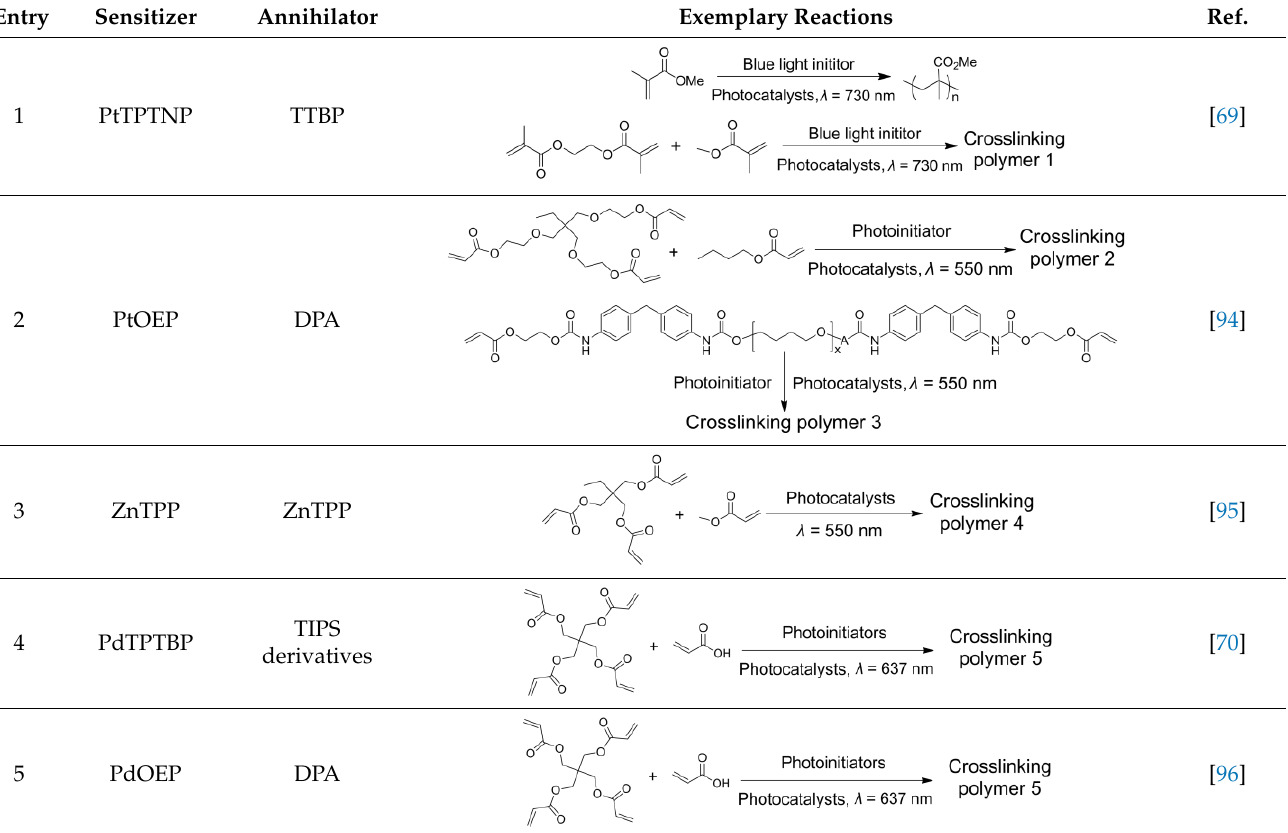
Table 2. Summarized photoinitiated polymerizations via porphyrin-based TTA-UC.